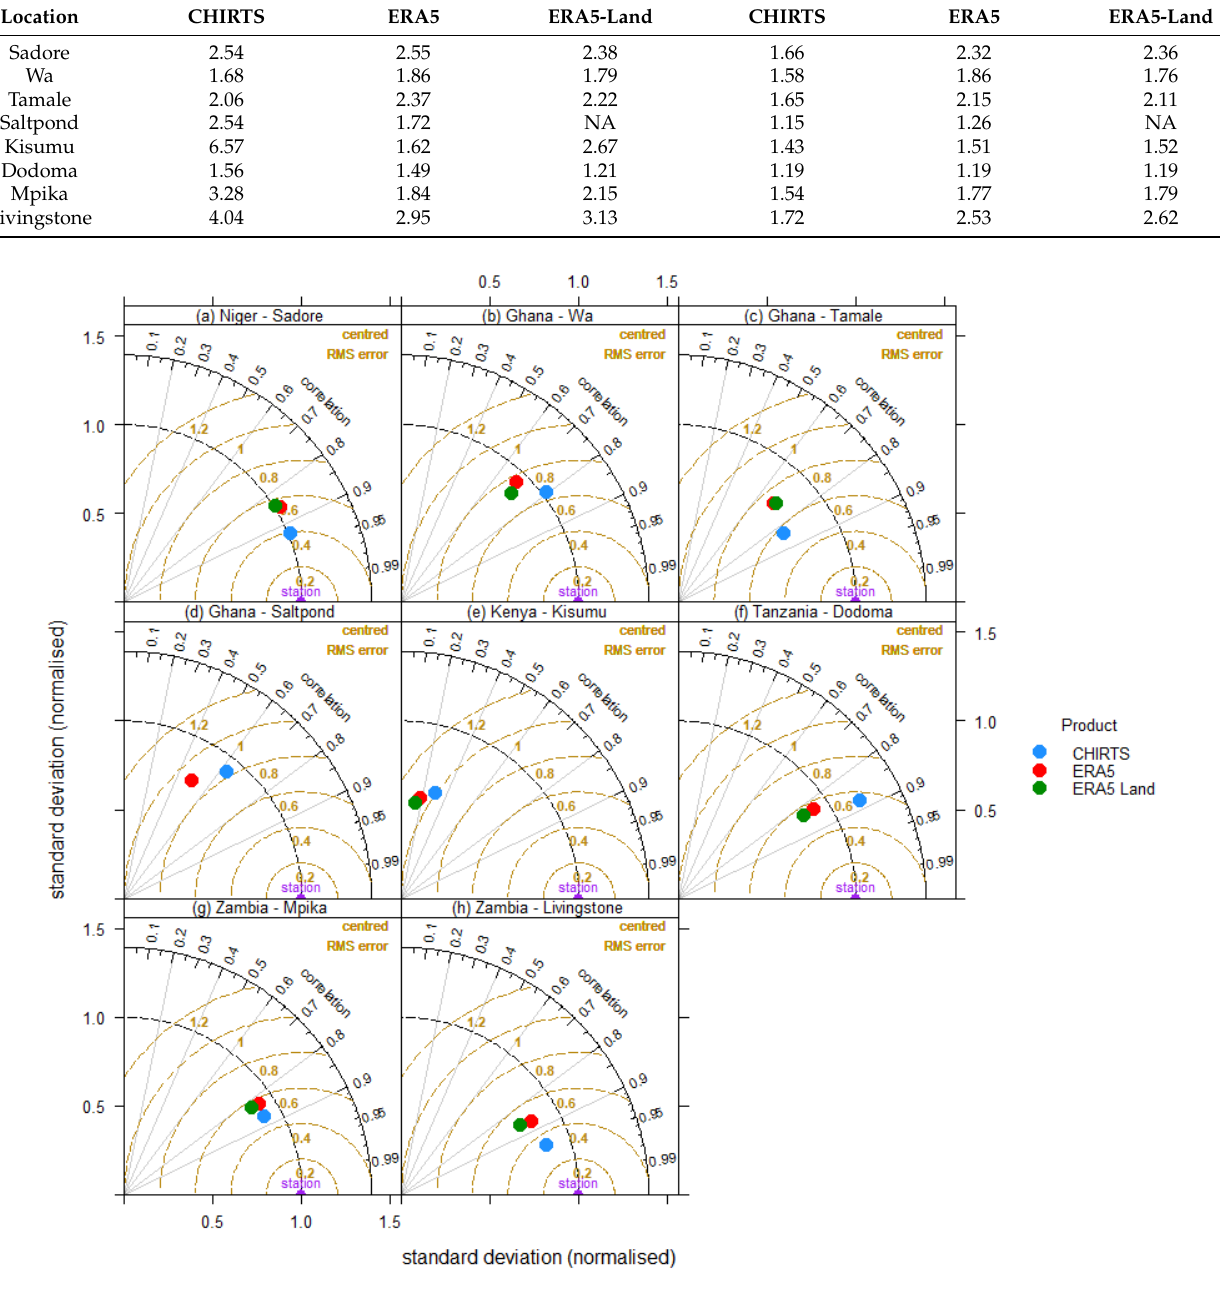
Figure 7. Taylor diagram comparing the performance of CHIRTS (blue), ERA5 (red) and ERA5 Land (green) with the station data (purple) by correlation, centered root mean square error and (normalized) standard deviation at the stations in Niger and Ghana ( a – d ) and Kenya, Tanzania and Zambia ( e – h ).